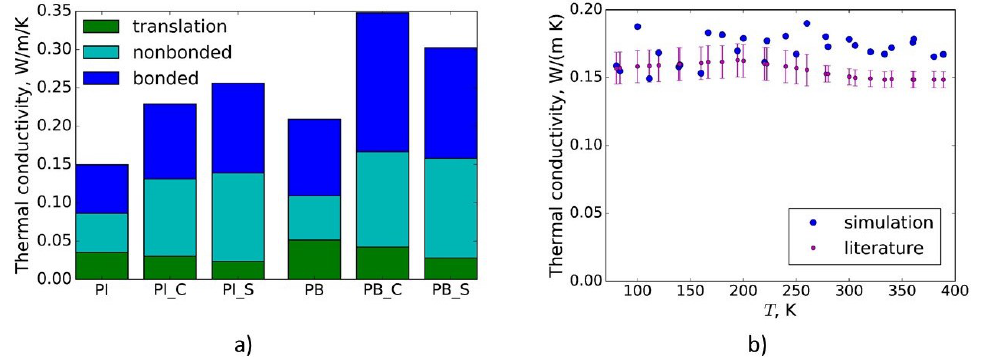
Figure 4. ( a ) Compositions of thermal conductivities of untreated polyisoprene (PI), vulcanized polyisoprene with C-C bridges (PI_C) with a degree of crosslinking of 80%, vulcanized polyisoprene with C-S-S-C bridges (PI_S) with degree of crosslinking 80%, untreated polybutadiene (PB), vulcan- ized polybutadiene with C-C bridges (PB_C) with a degree of crosslinking of 80%, and vulcanized polybutadiene with C-S-S-C bridges (PB_S) with a degree of crosslinking of 80%; ( b ) dependence of the thermal conductivity of polyisoprene crosslinked with C-S-S-C bridges (degree of crosslink- ing is 5.3%, which corresponds to 2.5 phr (parts per hundred rubber) of sulfur) on temperature at atmospheric pressure. For comparison, data from the literature on soft rubber from Ref. [23] are